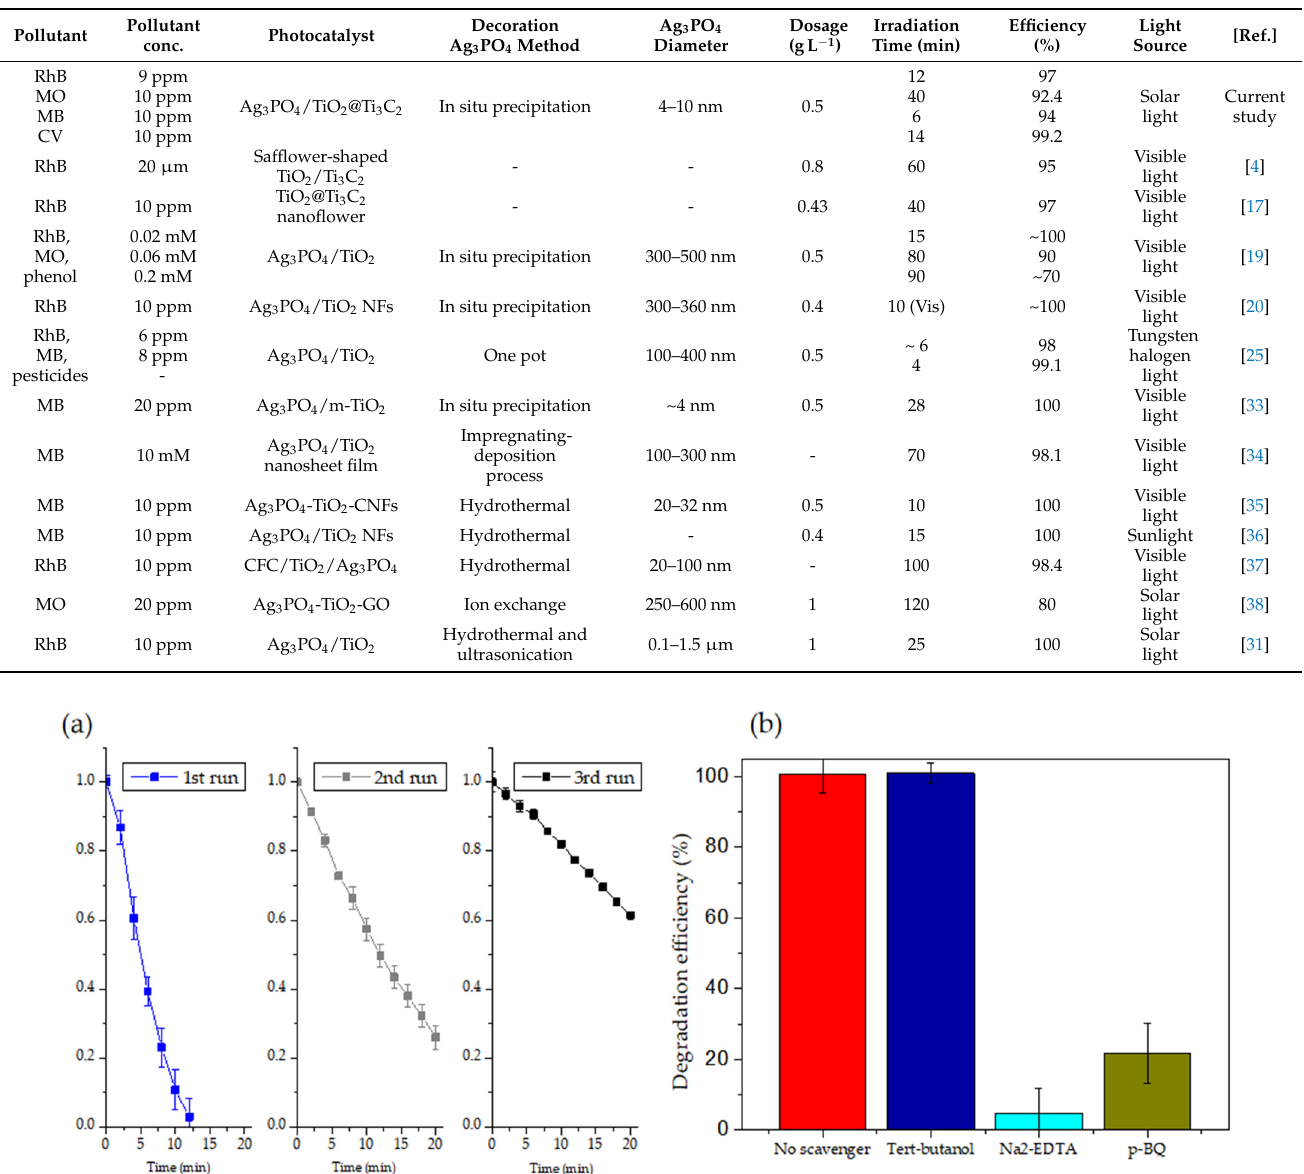
Table 2. A comparison of the photocatalytic efficiency of TiO 2 @Ti 3 C 2 and Ag 3 PO 4 -based photocata- lysts developed for dye degradation.